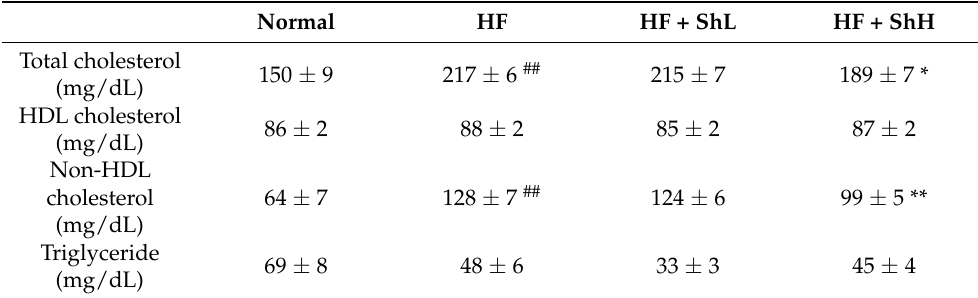
Figure 4. Effects of S. horneri on serum adipokine levels in C57BL/6J mice fed a high-fat diet for 13 weeks. Serum levels of adiponectin ( a ) and TNF- α ( b ) were determined using a commercial ELISA kit. Normal, normal diet; HF, high-fat diet; HF + ShL, high-fat diet mixed with 2% S horneri ; HF + ShH, high-fat diet mixed with 6% S. horneri . Each value represents the mean ± SEM ( n = 6 − 8). Significant difference: * p < 0.05, ** p < 0.01 vs. HF group, ## p < 0.01 vs. Normal group. Table 2. Effects of S. horneri on serum lipid